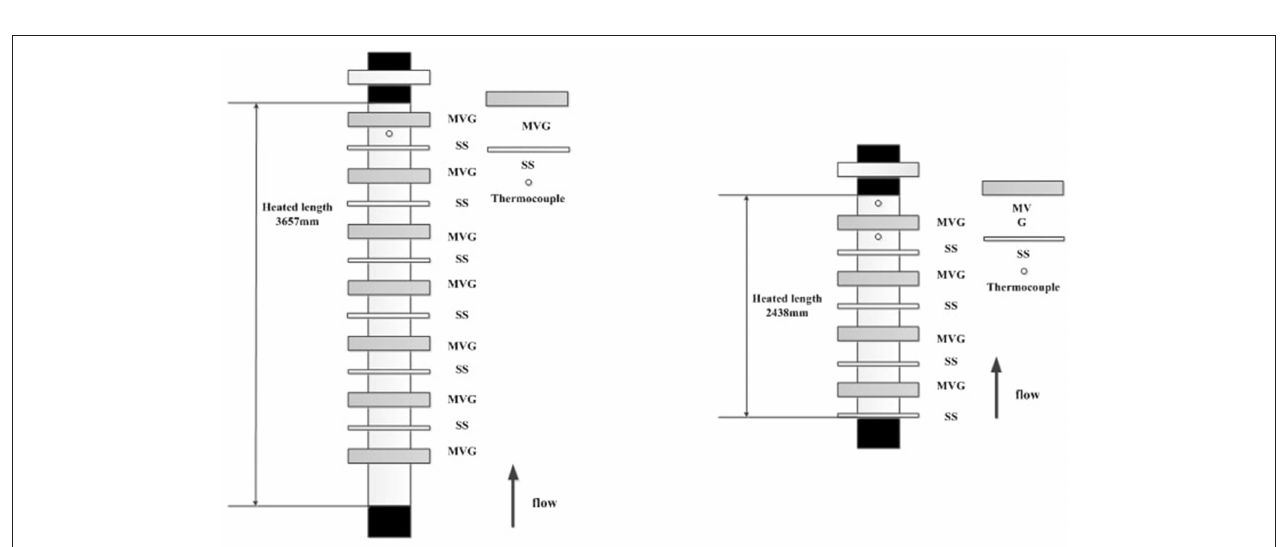
5 rod-bundle experiment (grids setup). ×